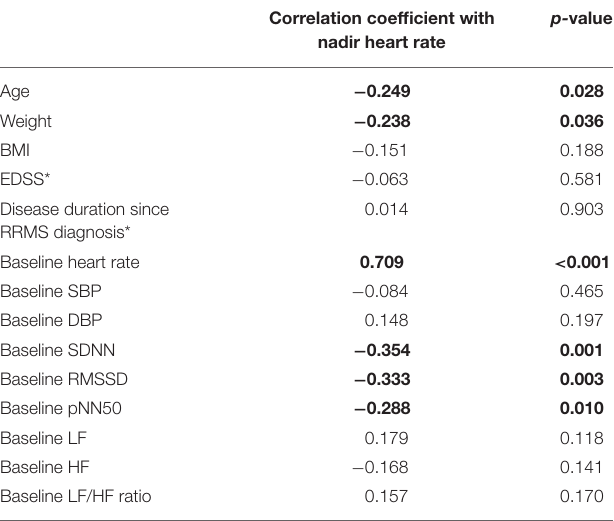
TABLE 2 | Correlation analysis between demographic, clinical, and cardiovascular parameters and nadir heart rate. Correlation coefficient with nadir heart rate